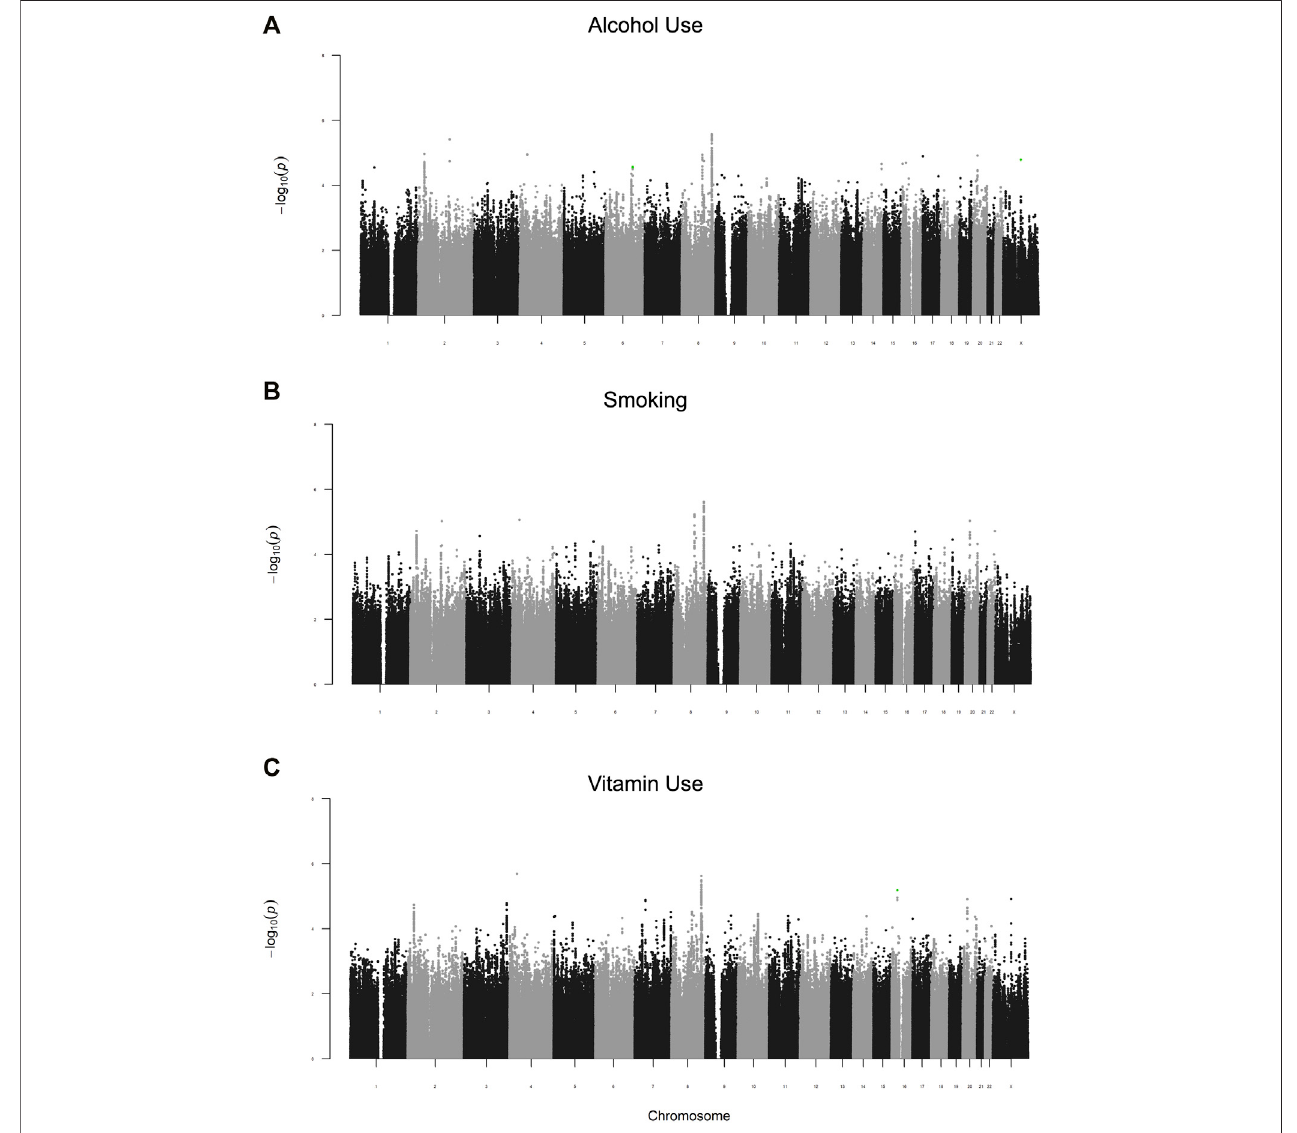
FIGURE1| Manhattan plotsoftheG-GE testfor maternalpericonceptional (A) alcoholuse, (B) smoking, (C) vitaminuse. SNPshighlighted ingreenare thosewith signi fi cant GE effects (p 2df < 0.05 and p GE < 4.8 × 10 – 6 ).